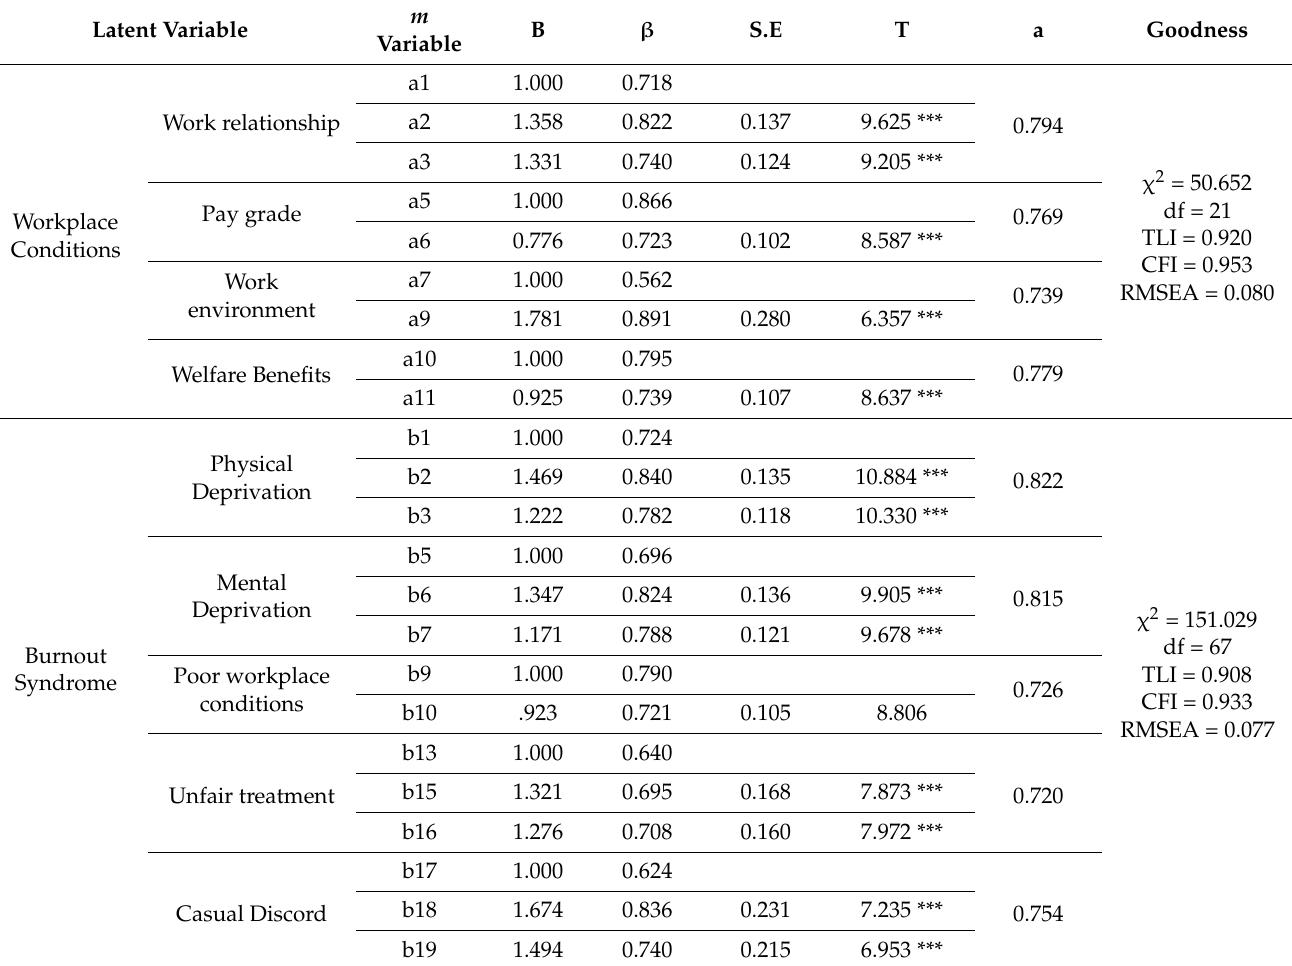
Table 2. Confirmatory factor analysis of each potential variable and reliability